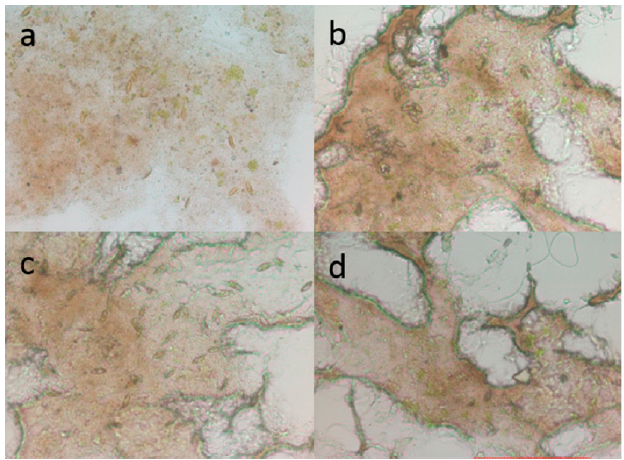
Figure 4. Microscopy examination of the ABS system during a reaction run on the ( a ) second day, ( b ) fourth day, ( c ) sixth day and ( d ) eighth day.